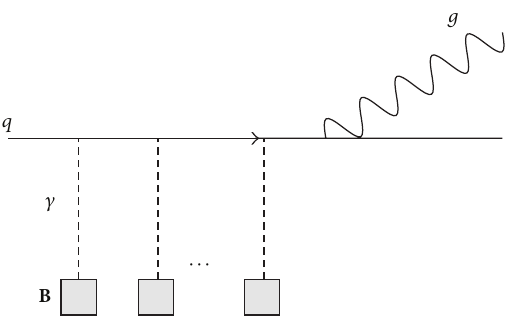
Figure 6: A typical diagram contributing to the synchrotron radiation by a quark.